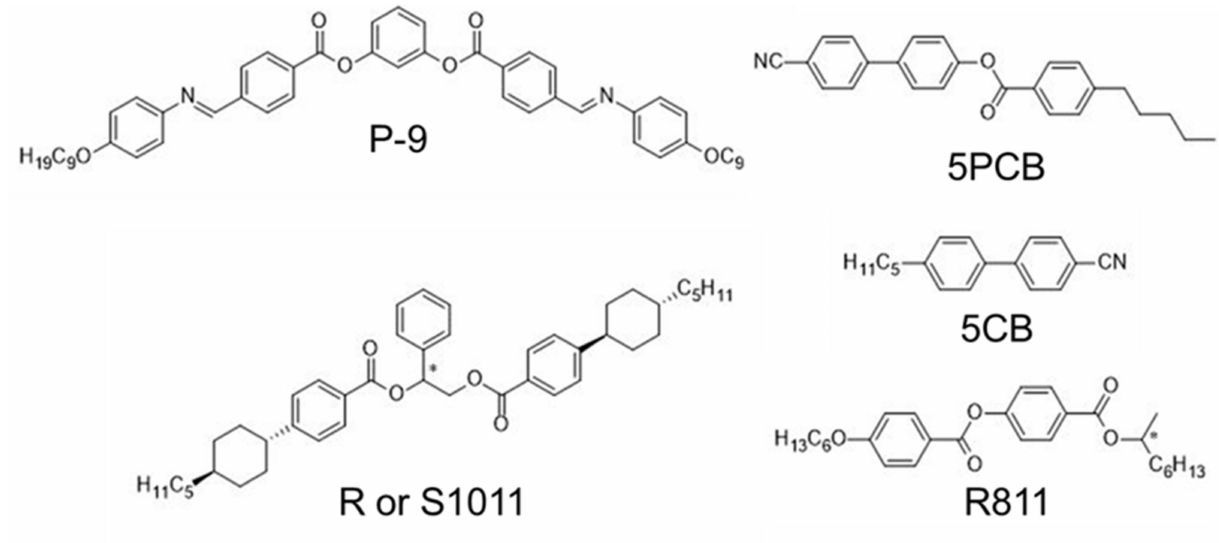
Figure 2. Chemical structures of materials used in this study (bent-core (BC) molecule: P-9; rod-like molecules: 5PCB and 5CB; chiral dopants: R or S1011,